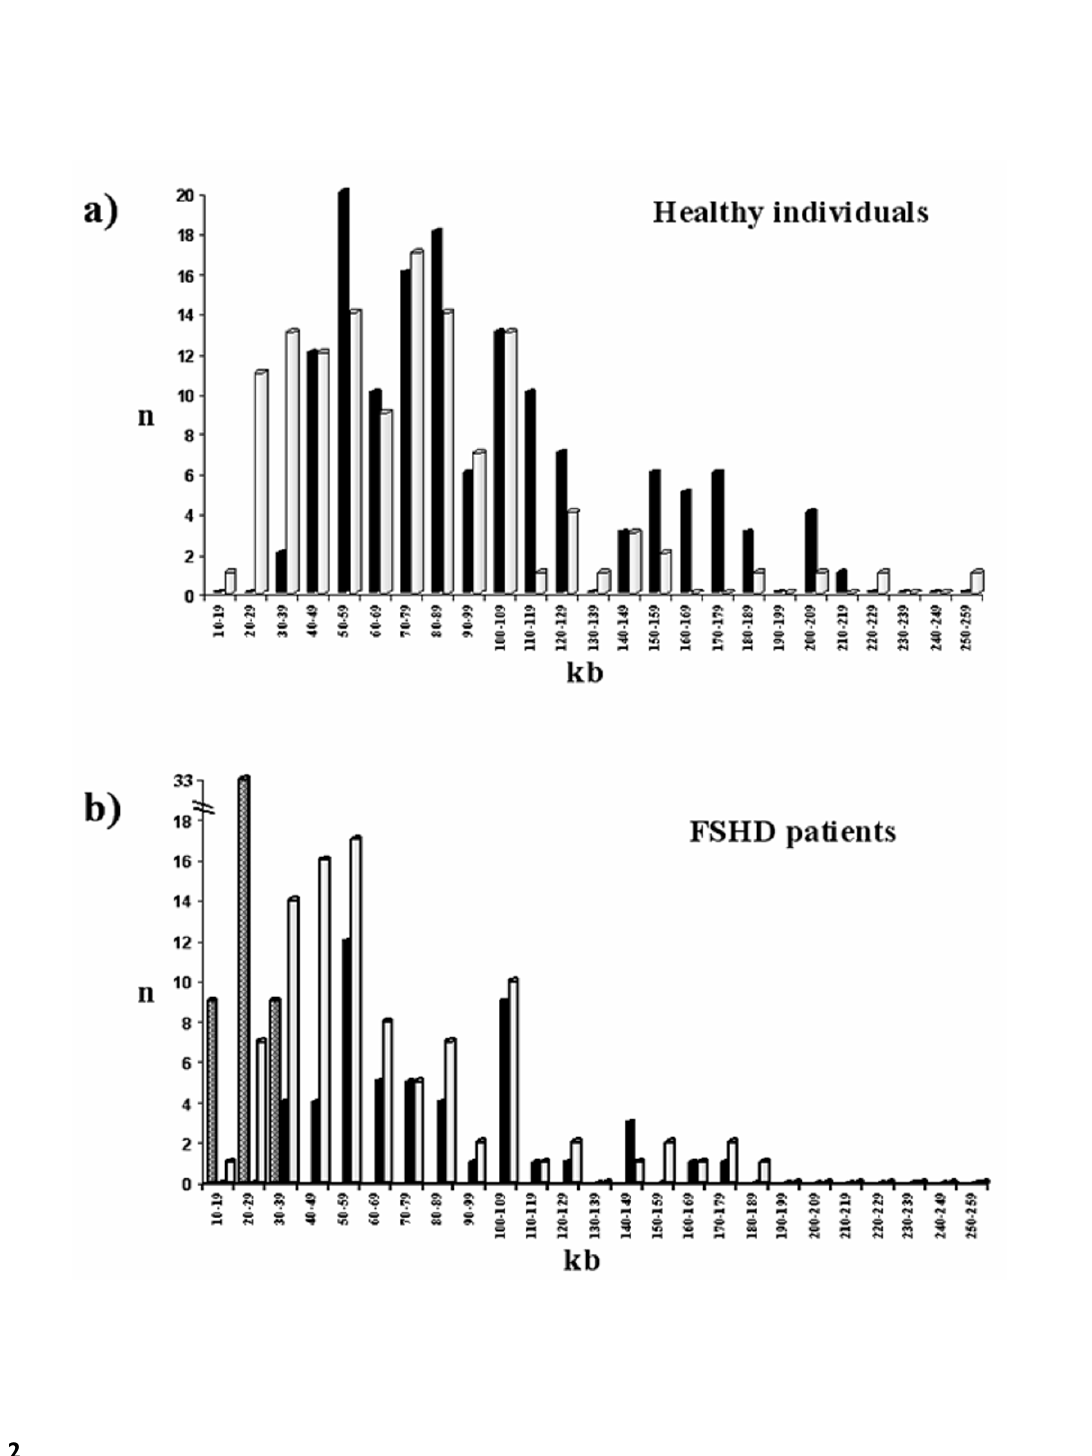
Figure 2 Size distribution of 4q and 10q alleles in healthy and FSHD affected subjects . The size distributions of 4q and 10q alleles detected in healthy subjects (panel a) and FSHD patients (panel b) are represented. The size of EcoRI fragments is expressed in kb, with 10 kb intervals. Black bars: 4q wild-type alleles; grey bars: disease-associated 4q alleles; white bars: 10q